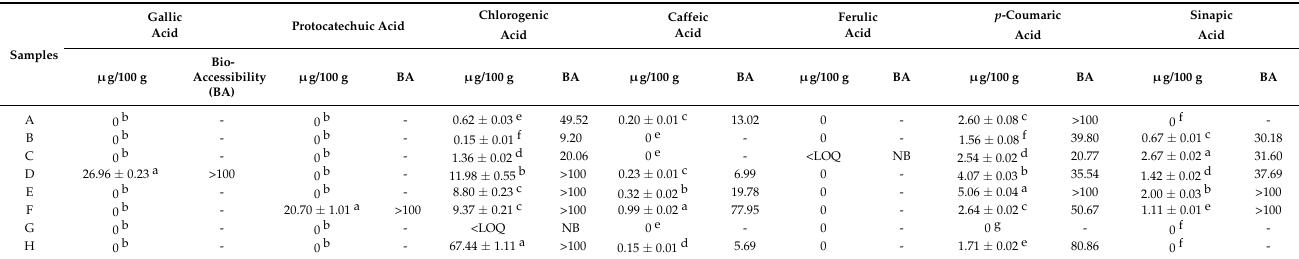
* The data is presented as the mean ( n = 3) ± S.D. Different letters within each column indicate significant differences between treatments according to Tukey’s test at p <